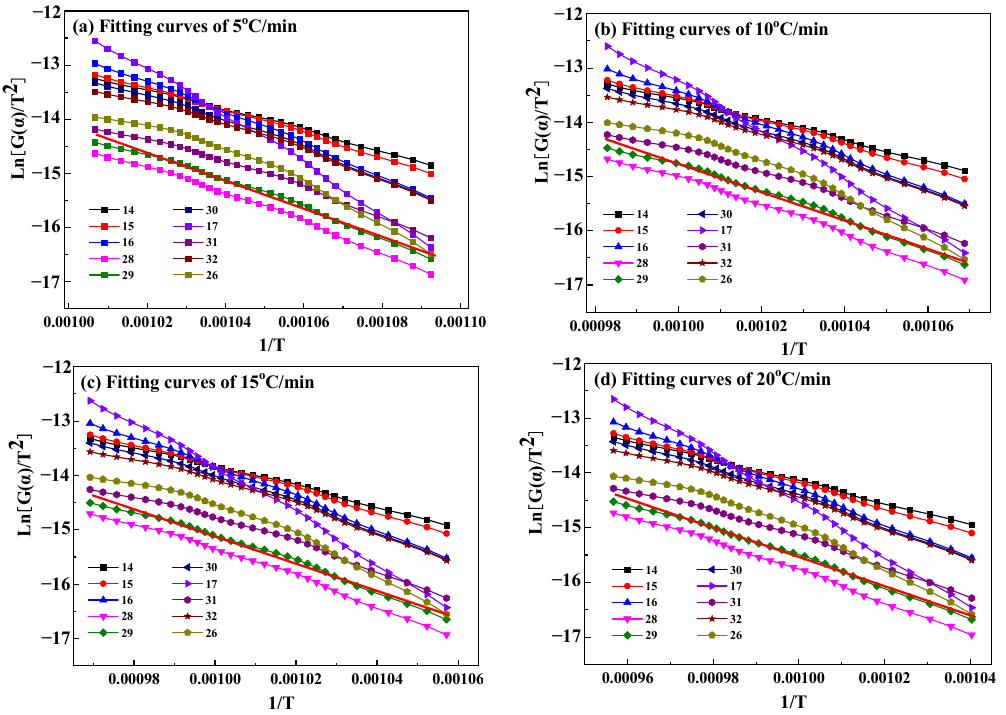
Figure 7. Kinetic fitting curve using the general integration method. The correlation coefficients r for No. 29, 30, 31, 32, and 15 in Figure 7 exceeded 0.99. The mean values of the fitting results for the four warming rates are listed in Table 3. Table 3. Fitting results for the top five G( α ).